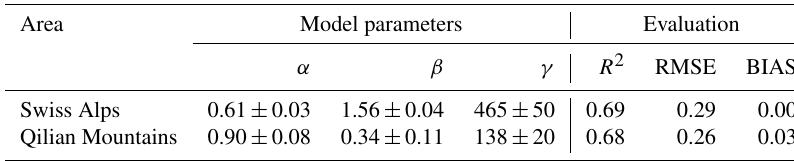
Table 4. Summary of model parameters for estimating LSCF from